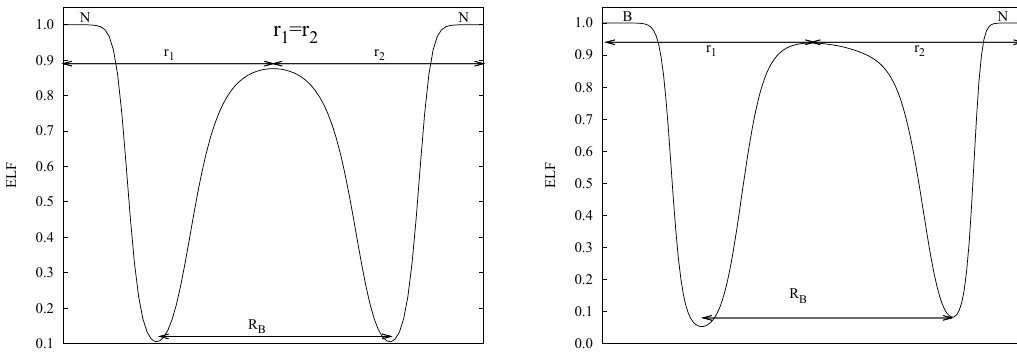
; r =r ] , for a B 1 2